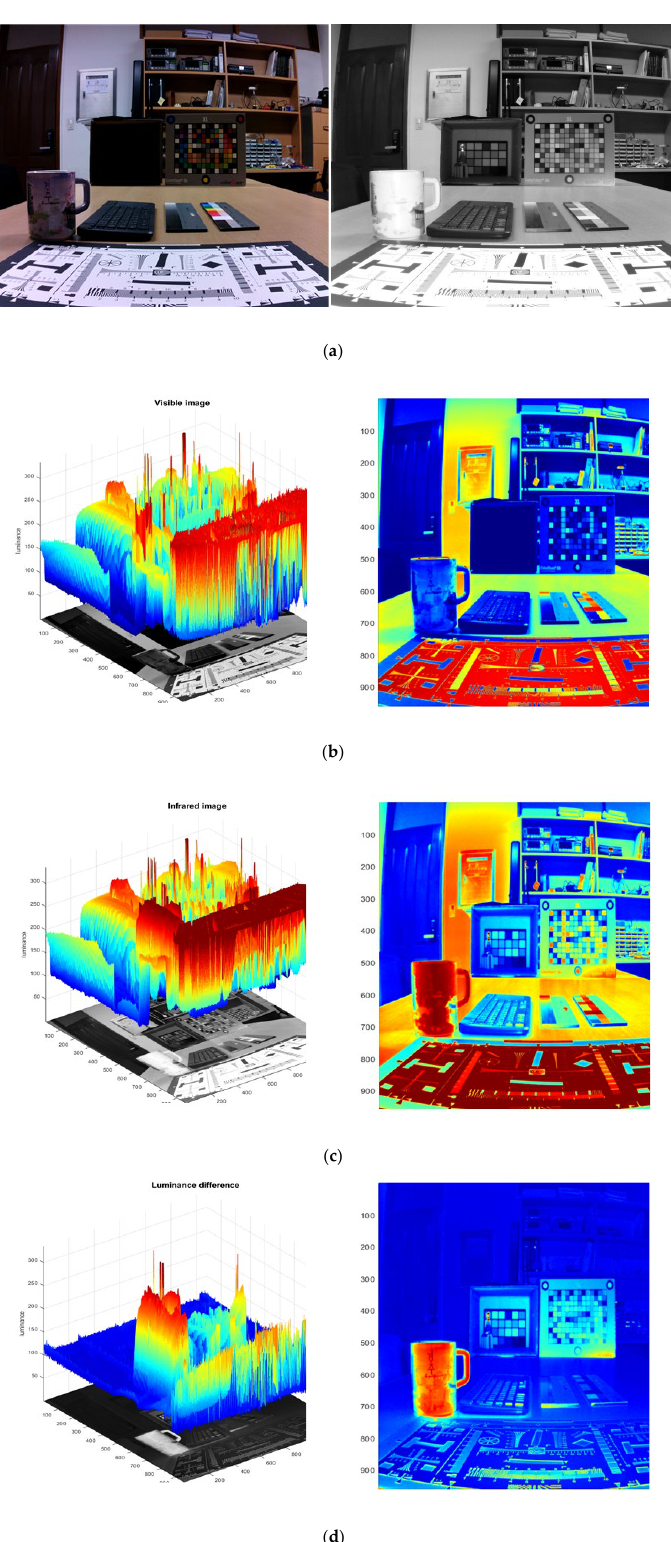
Figure 9. Color maps of nighttime images: ( a ) night visible and near-infrared images, ( b ) night visible images, ( c ) night near-infrared images, ( d ) difference images between nighttime visible and near-infrared.